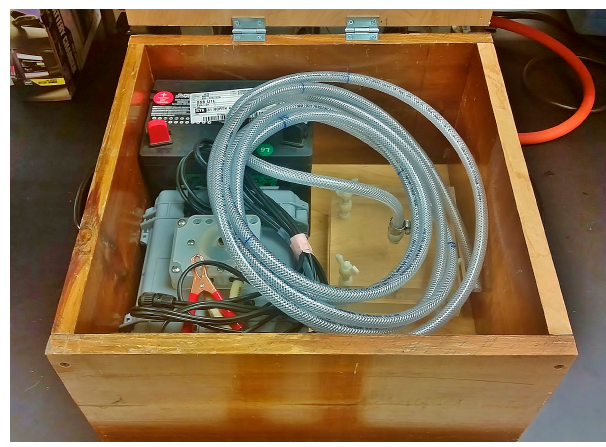
Figure 1. Assembly of the water sampler. ( A ) Collection of all components. Clockwise from top right : bottom acrylic square for sampling device; top acrylic square for sampling device fitted with barbed nylon fitting for attaching tubing; four nylon spacers (each 1 cm tall with 5/16-inch I.D.); four 5/16-inch × 4-inch nylon bolts; four 5/16-inch I.D. nylon washers; and four 5/16-inch nylon wing nuts. ( B ) Four holes were drilled at each corner of the acrylic squares using a drill press and a 5/16-inch drill bit. The pieces were taped together to retain alignment of the holes. The holes were drilled slowly to avoid warping or cracking of internal acrylic. ( C ) The bolts were inserted upwards through each of the four holes in the bottom square of the sampler. ( D ) 1 cm spacers were slid onto each bolt. ( E ) The top square of the sampling device was slid into place over the four bolts and rested on the spacers. ( F ) Washers and wing nuts were secured onto the bolts to complete the sampler.